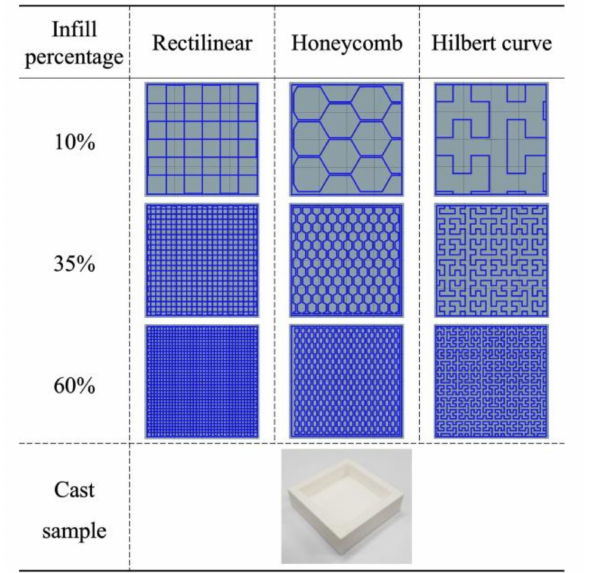
Figure 3. 3D design in the form of a square with a side length of 40 mm, with various internal designs.